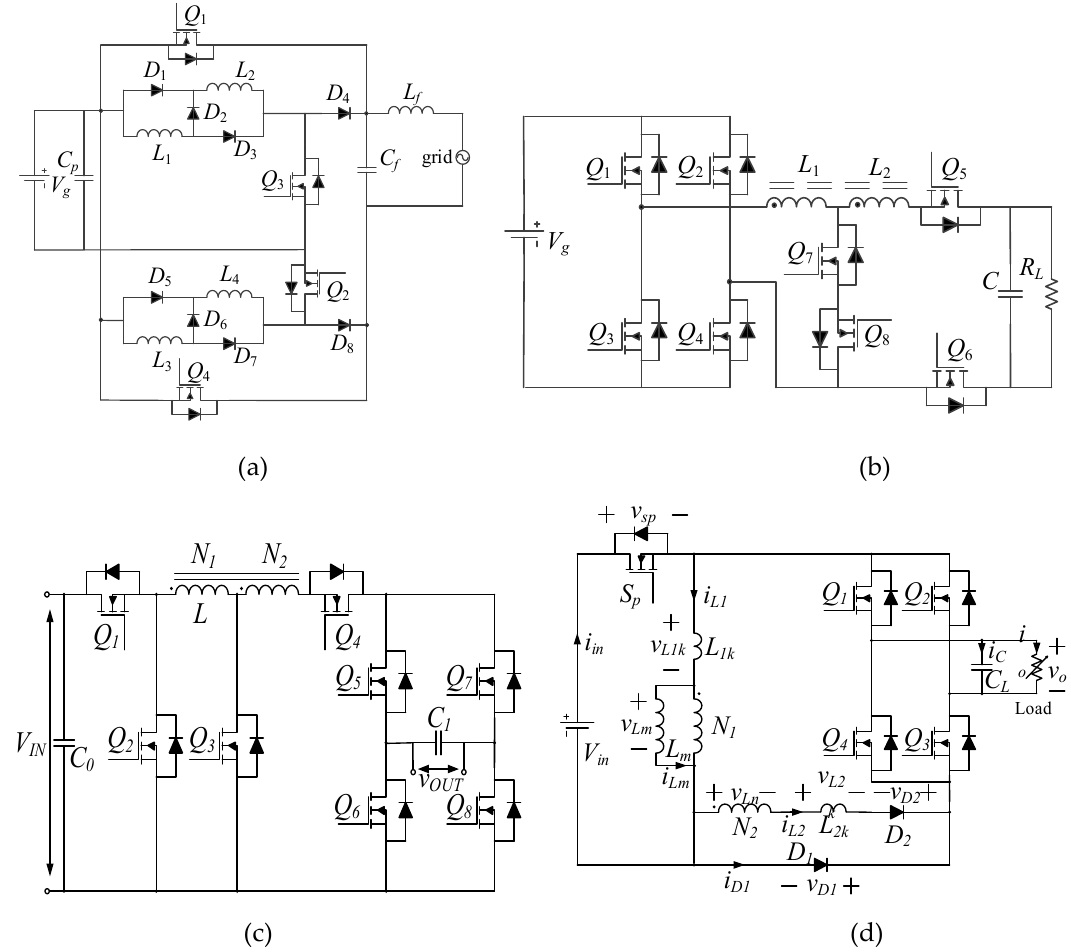
Figure 2. Prior-art, single-stage, buck-boost inverters with high gains: ( a ) [22], ( b ) [23], ( c ) [24], and